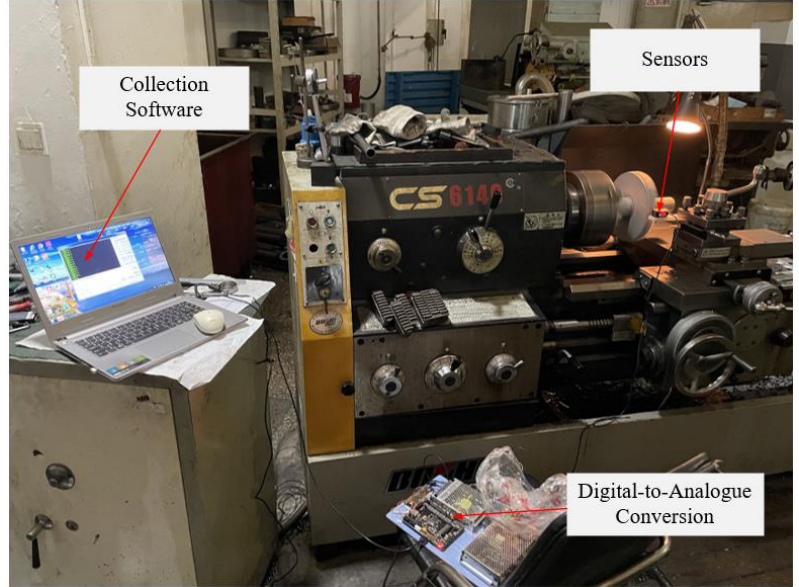
Figure 5. Coaxiality acquisition device.